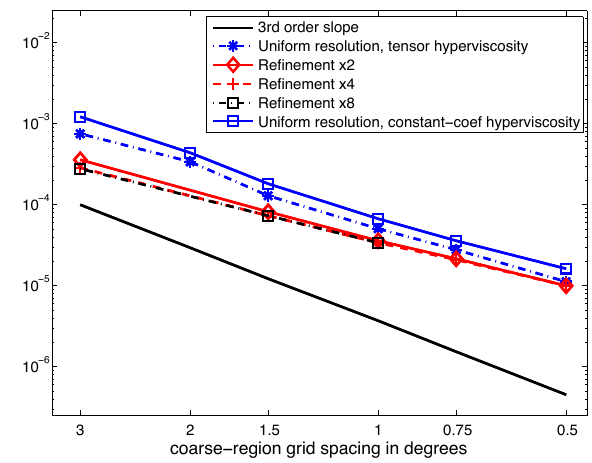
Figure 11. TC2 l 2 errors for uniform and low-connectivity grids plotted as a function of (cid:49)x low . The solid line shows fourth-order convergence. The error is controlled by the coarse region (cid:49)x low and the SEM obtains its formal order of accuracy (fourth order for p = 3) with respect to (cid:49)x low . This is true for both uniform grids (blue squares and blue stars) and grids containing mesh re- fined regions with (cid:49)x high = (cid:49)x low / 2 ( × 2 family, shown as red di- amonds), (cid:49)x high = (cid:49)x low / 4 ( × 4 family, shown as red plus marks), and (cid:49)x high = (cid:49)x low / 8 ( × 8 family, shown as black squares). All curves are practically indistinguishable.